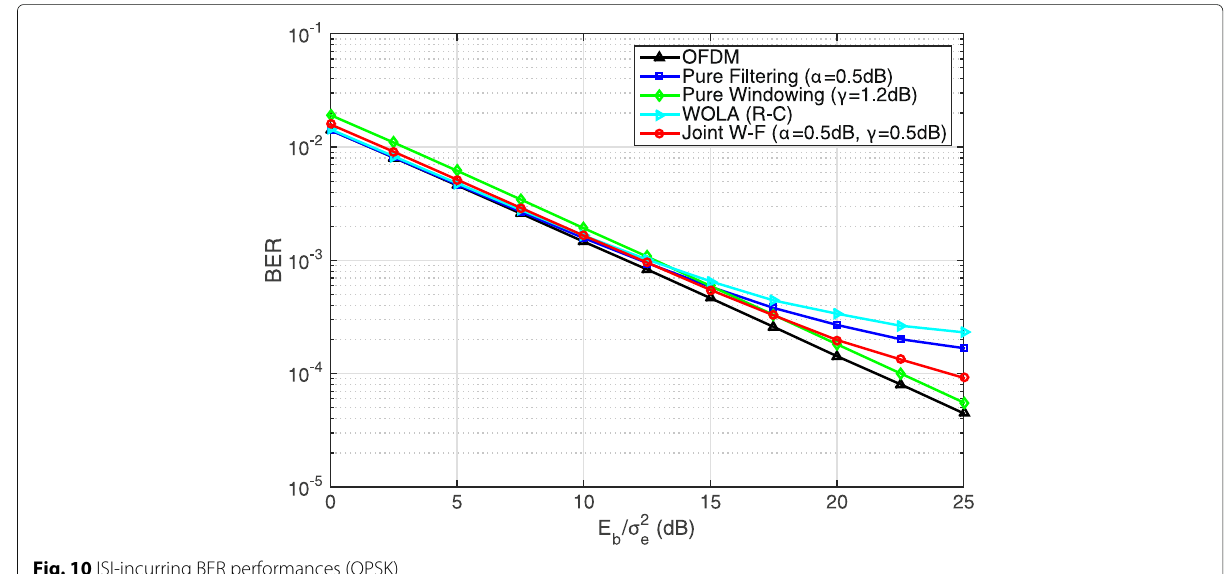
Fig. 10 ISI-incurring BER performances (QPSK)